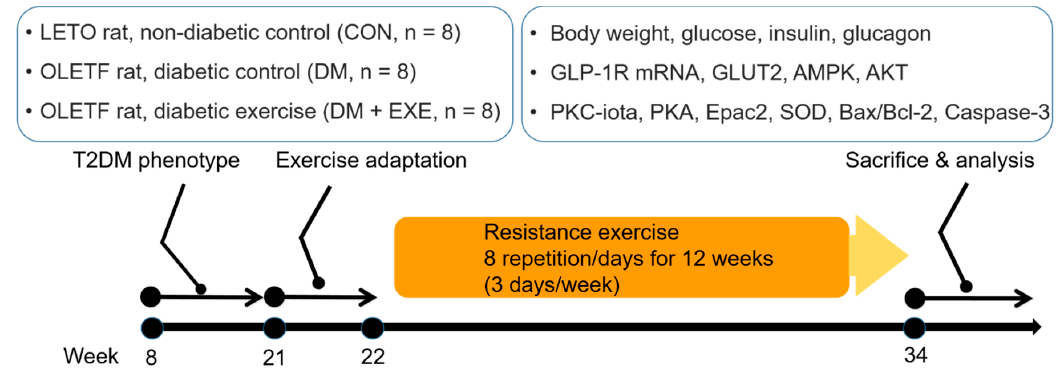
Figure 1. Schematic of experimental design. T2DM: type 2 diabetes mellitus; LETO: Long-Evans Tokushima Otsuka; OLETF: Otsuka Long-Evans Tokushima Fatty; GLP-1R: Glucagon-like peptide-1 receptor; GLUT2: glucose transporter 2; AMPK: adenosine monophosphate-activated protein kinase;